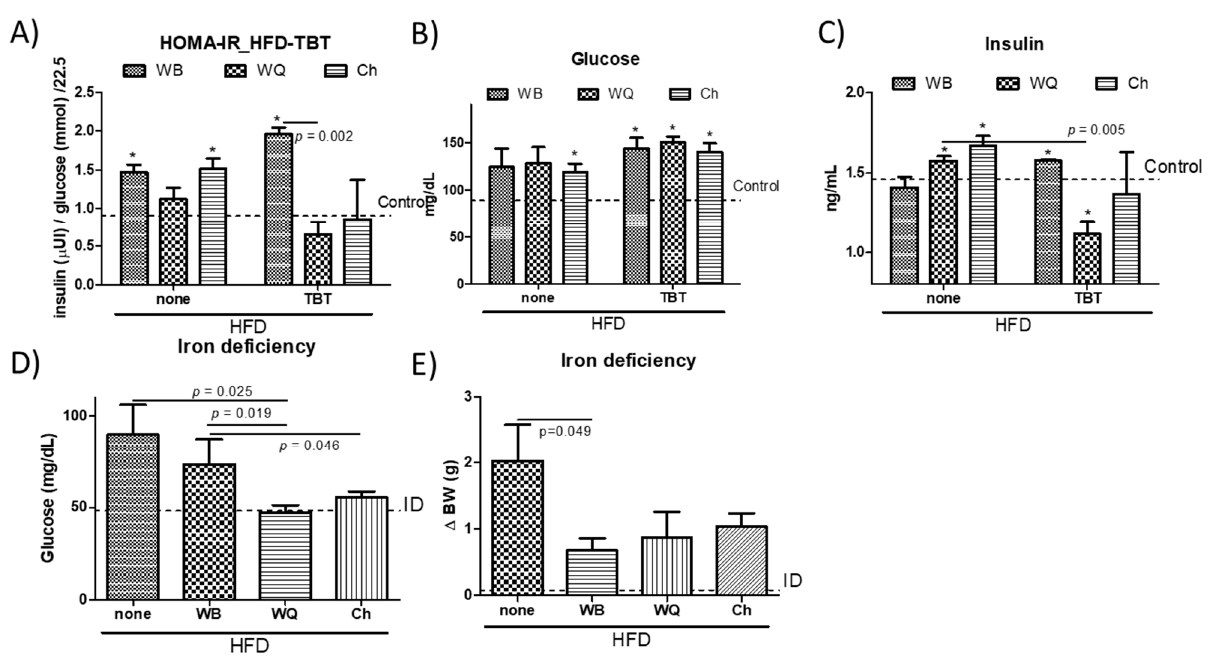
Figure 4. Biochemical parameters (HOMA-IR, A ; glucose, B and insulin, C ) in wild type and tributyltin (TBT)-exposed mice, glucose levels in iron-deficient (ID) ( D ) animals and body weight gain in ID animals ( E ), all fed with a high-fat diet and administered with different bread formulations: WB, wheat bread; WQ, white quinoa flour (25%)–containing bread and Ch, chia flour (20%)–containing bread. Results are expressed as mean ± mean standard error ( n = 6). Untreated controls are represented by the dotted line. * indicates statistically significant ( p < 0.05) differences in relation to controls.